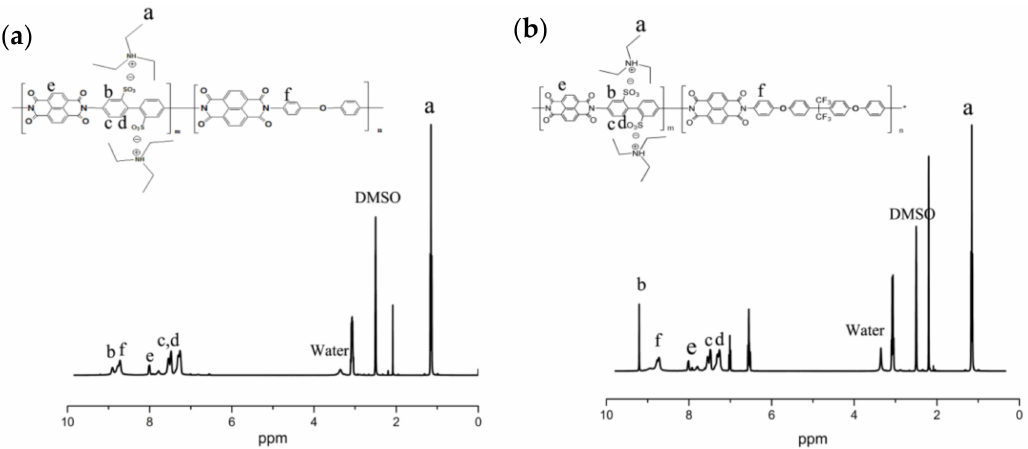
Figure 2. 1 H-NMR spectrum of SPI-ODA and SPI-HFBAPP. ( a ) SPI-ODA; ( b